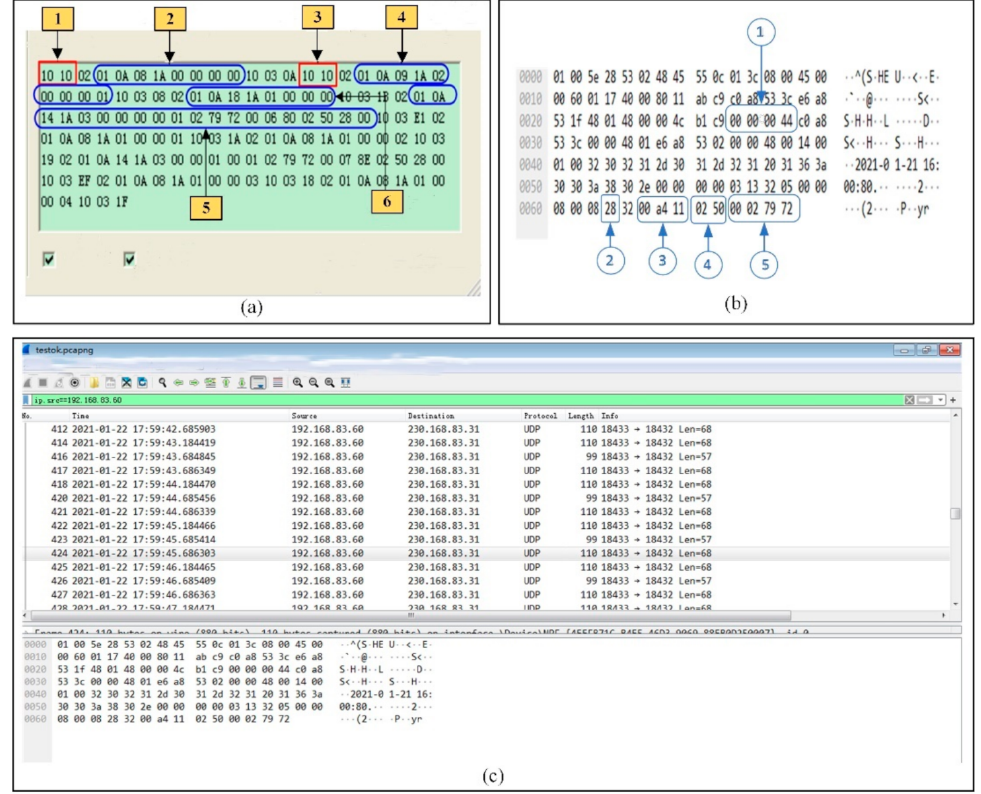
Figure 12. System grab packet: ( a ) send and reply message for 3964(R) protocol, ( b ) the specific content of the UDP message, and ( c ) use the packet capture software to obtain the UDP